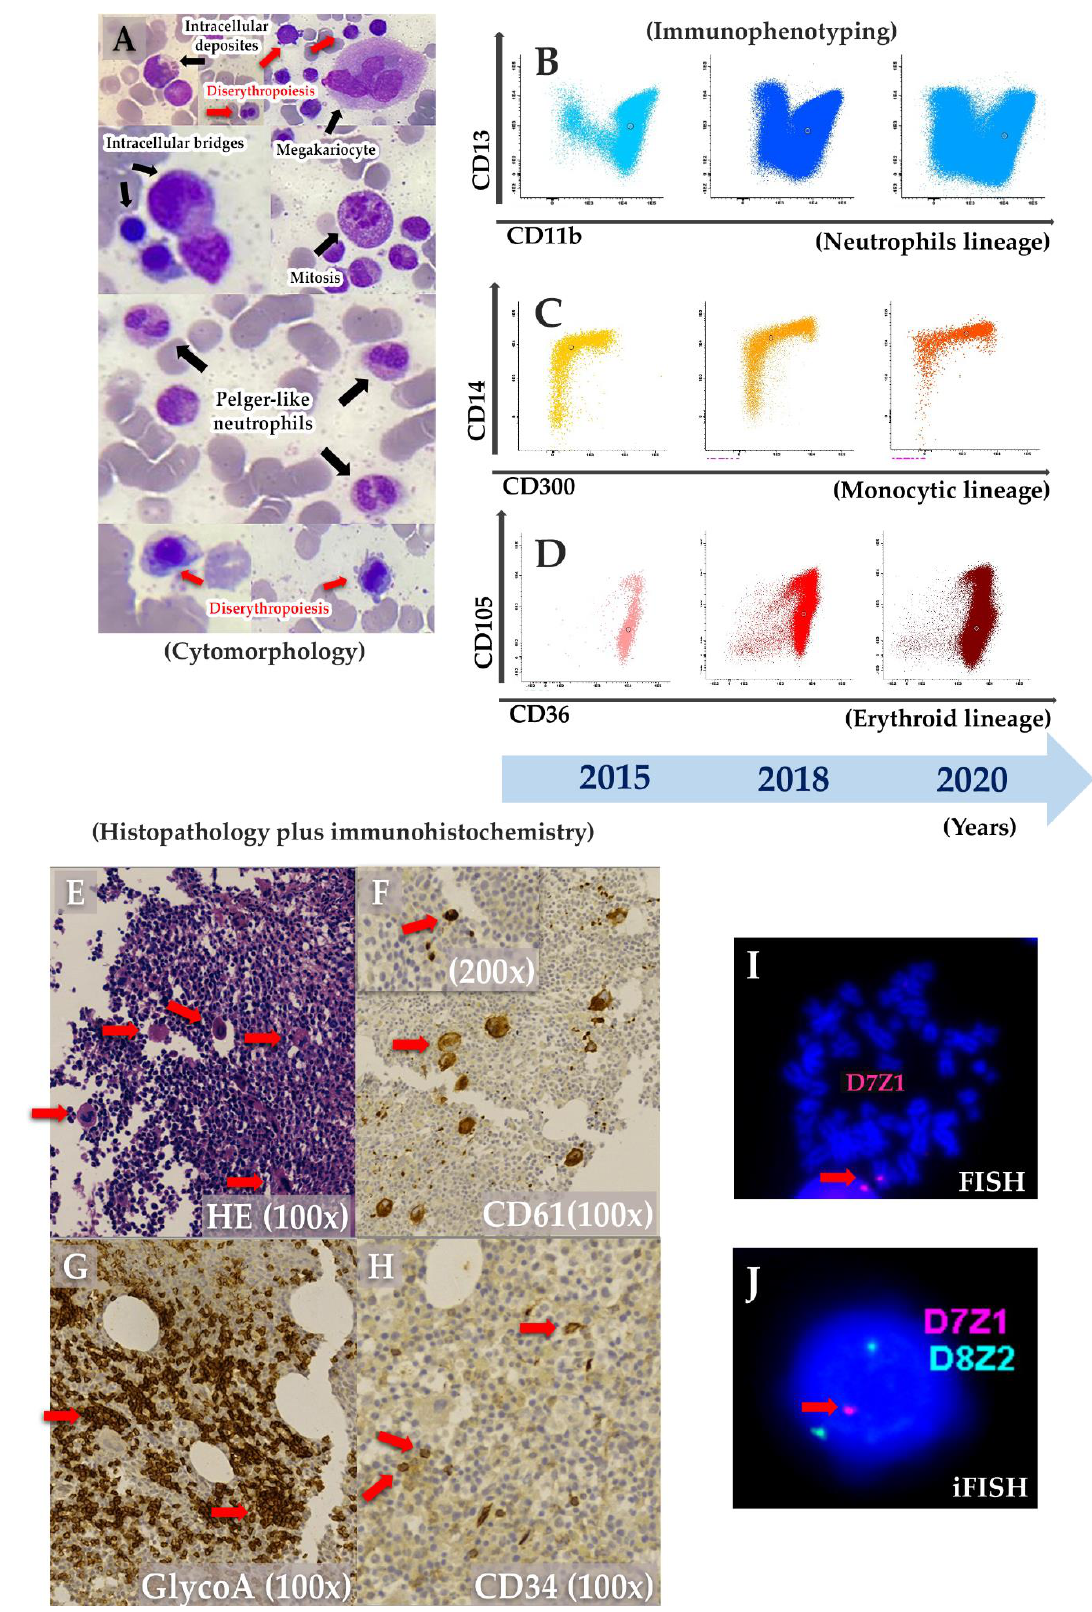
Figure 2. Bone Marrow (BM) aspirate was characterized with ( A ) cytomorphology stained with MayGrunwald-Giemsa (MGG) that revealed myelodysplastic characteristics (dyserythropoiesis, dysmegakaryopoiesis, intercellular bridges, Pel-guer-huet-like neutrophils and mitosis figure); ( B – D ) immunophenotyping sequentially performed a long of time that